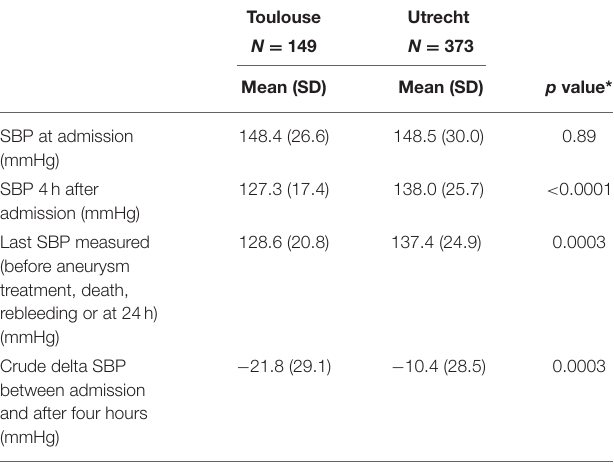
TABLE 2 | Evolution of systolic blood